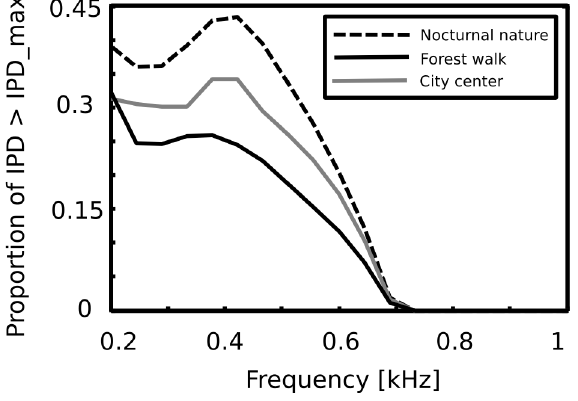
Figure 7. Proportion of IPDs exceeding the ‘‘maximal IPD’’ threshold plotted as a function of frequency. In each auditory environment a substantial amount (up to 45% in the 400 Hz channel of the nocturnal scene) of low-frequency IPDs exceeded the limit imposed by the size of the head. While such IPDs can carry relevant information, they can not be used to identify sound source position without additional transformations.